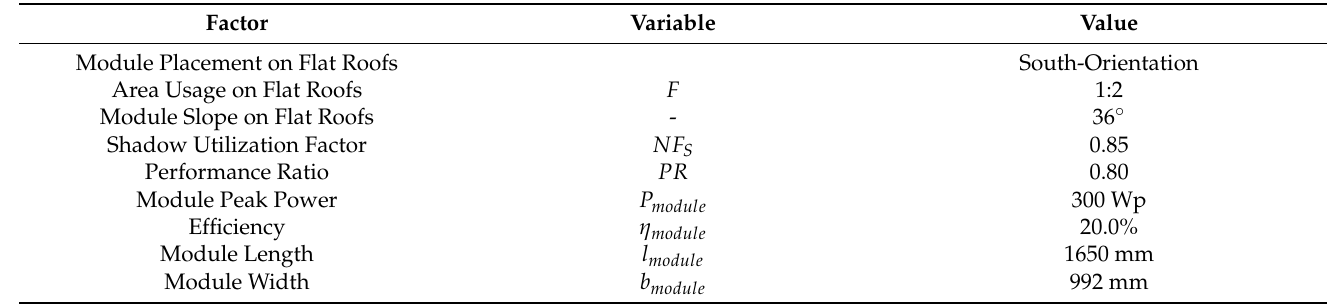
Table A3. Summary of technical